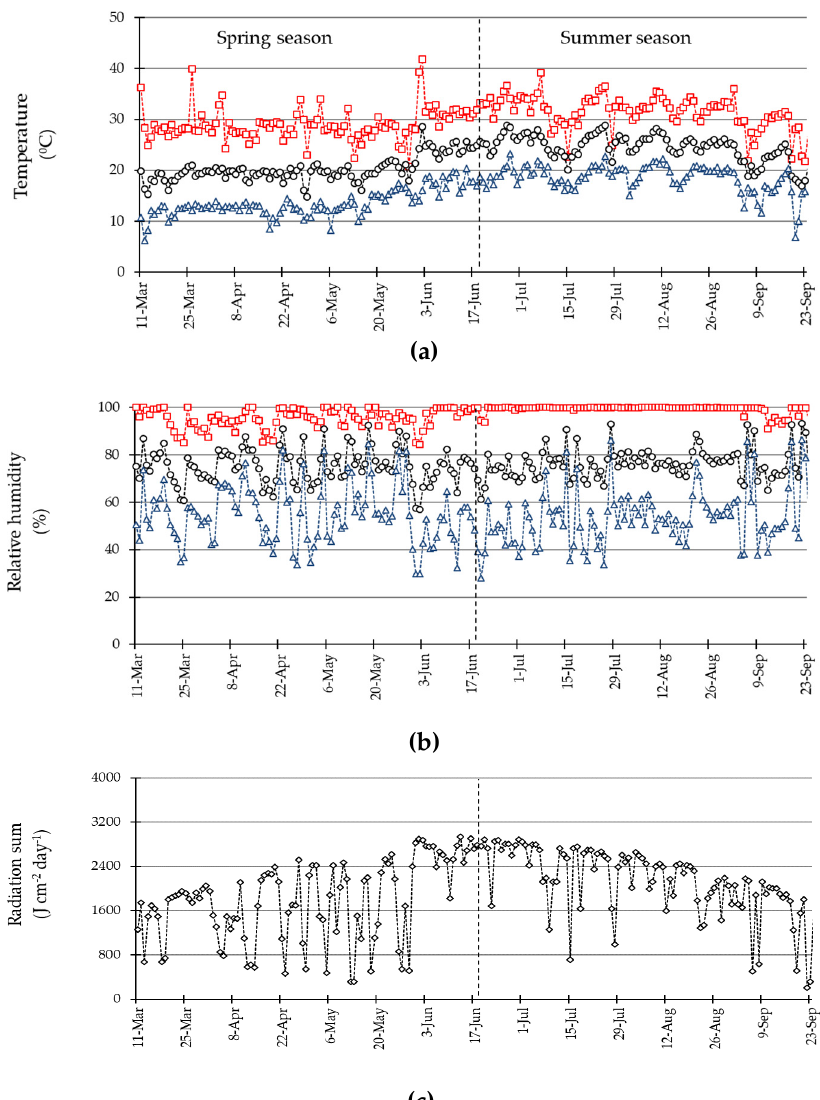
Figure 3. Environmental parameters at iPOM greenhouse. ( a ) Daily maximum (red squares), minimum (blue triangles), and average (black circles) temperatures; ( b ) daily maximum (red squares), minimum (blue triangles), and average (black circles) relative humidity; and ( c ) external (outdoor) daily radiation sum during growing cycle.